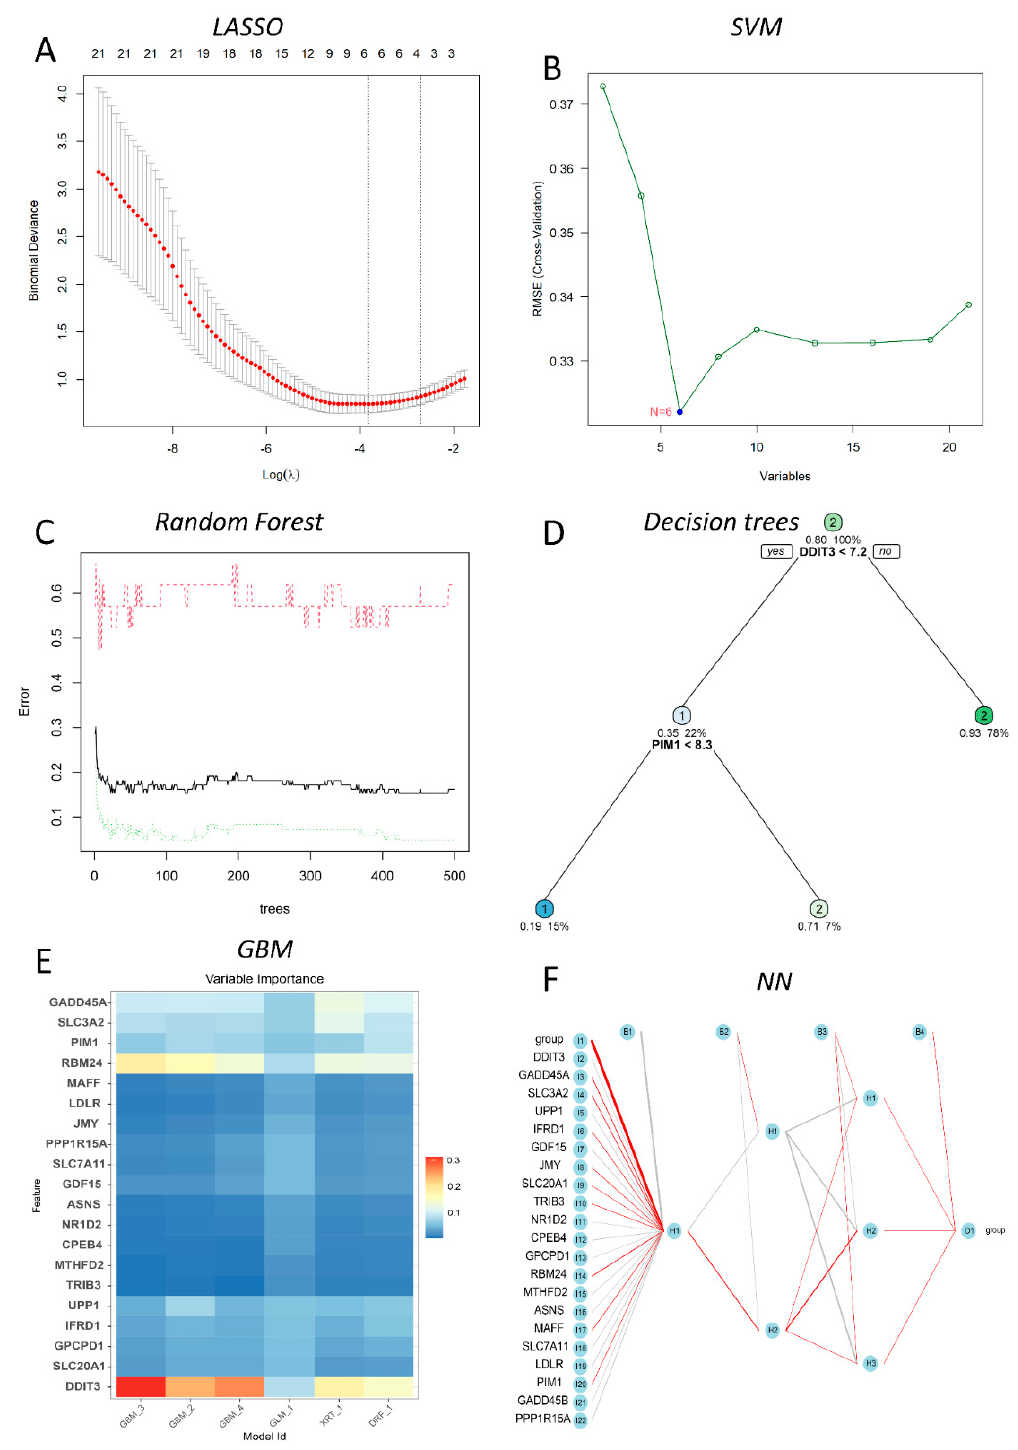
Figure 4. Six ML algorithms developed for DILI diagnosis. ( A ) LASSO for 4 prognostic DEGs (the bottom and top abscissa shows the Log( λ ) value and number of variables; the ordinate show the binomial deviance); ( B ) SVM for 21 prognostic DGEs (the abscissa shows the number of variables, and the ordinate shows the root mean square error); ( C ) RF for the classification of control and DILI individuals (the abscissa shows the error change with the number of the ordinate trees); ( D ) the optimal decision trees for the classification of control and DILI individuals with the gene-expression values and allocated probability; ( E ) six-fold in GBM for the classification of control and DILI individuals (the variable importance for each gene of multiple GMB models); ( F ) NN for the classification of control and DILI individuals with three hidden layers. Table 1. The error rate of the six MLs. MLs Training Set (%) Testing Set (%) Lasso